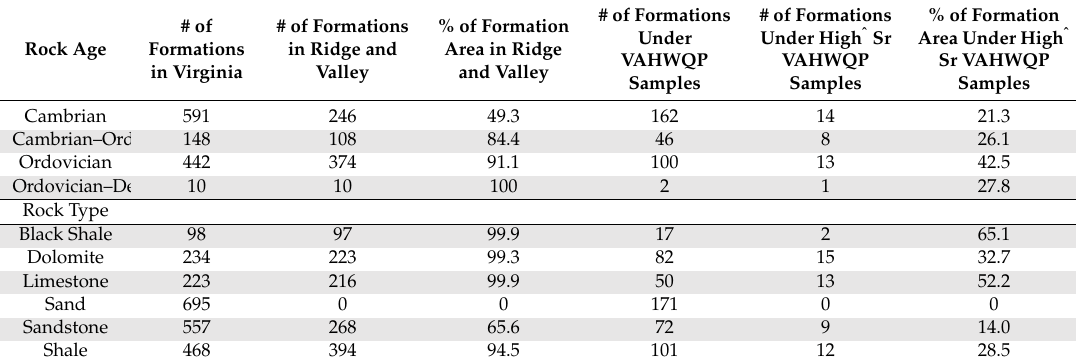
Table 4. Results of rock formation